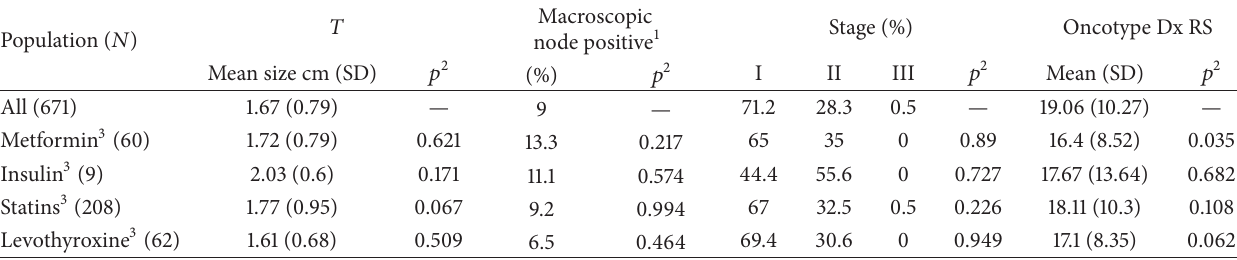
Table 1: Tumor burden and Oncotype DX recurrence